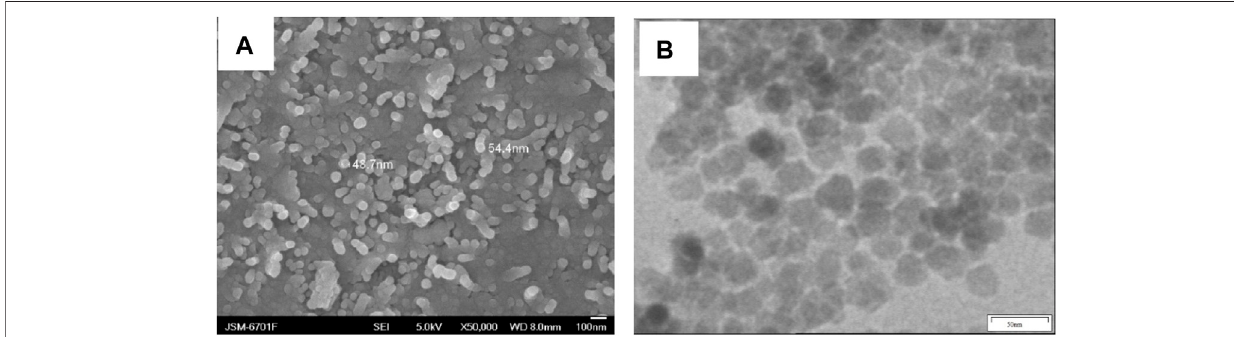
FIGURE 1 | SEM and TEM images of Fe 3 O 4 @ PNIPAM-b-PAzoMA nanoparticles.